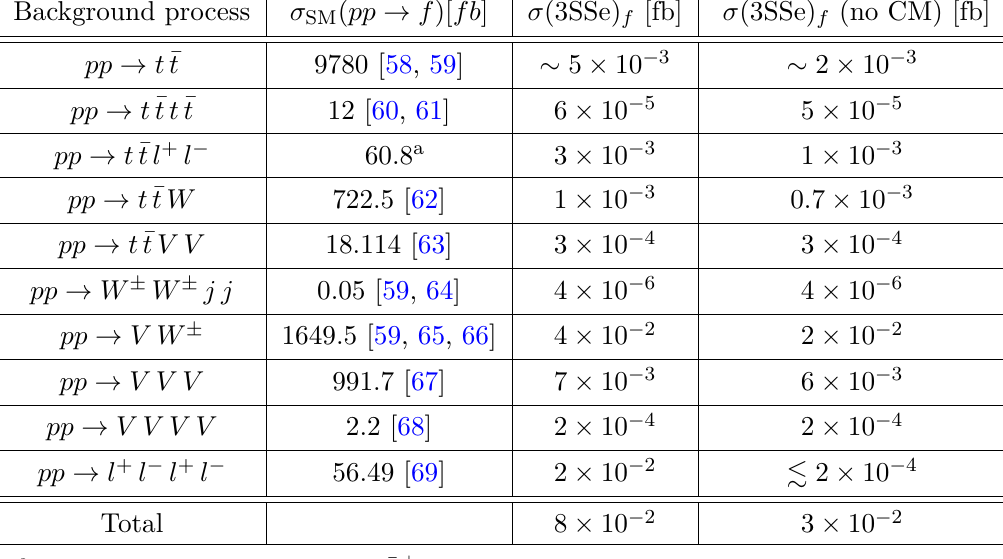
Table 5 . SM background cross sections, with and without charge mismeasurement, computed for √ s = 13 TeV. In our calculations, we use the central values of σ SM ( pp → f ) and take into account the branching ratios of the decay modes presented in the second column of table